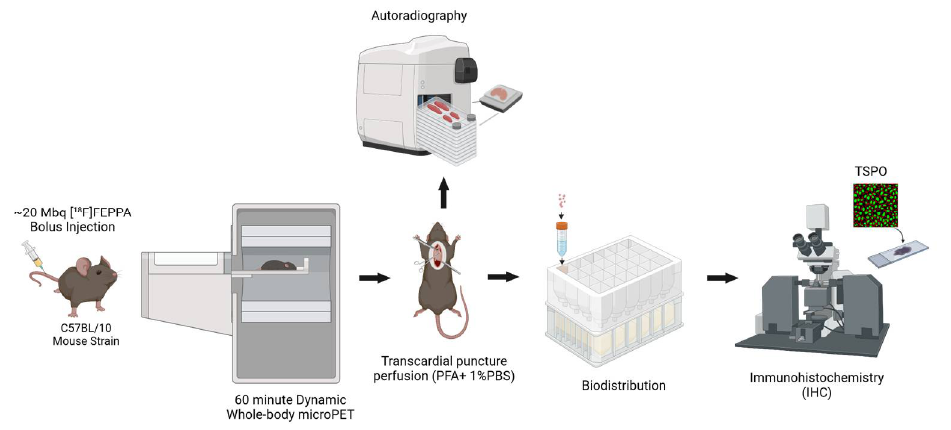
Figure 2. Experimental protocol for simultaneous in vivo [ 18 F]FEPPA PET imaging and ex vivo histopathology confirmation for assessing multi-organ inflammatory involvement in DMD mice models. PFA = paraformaldehyde; PBS = phosphate-buffered saline; TSPO = (18 kDa) translocator protein.